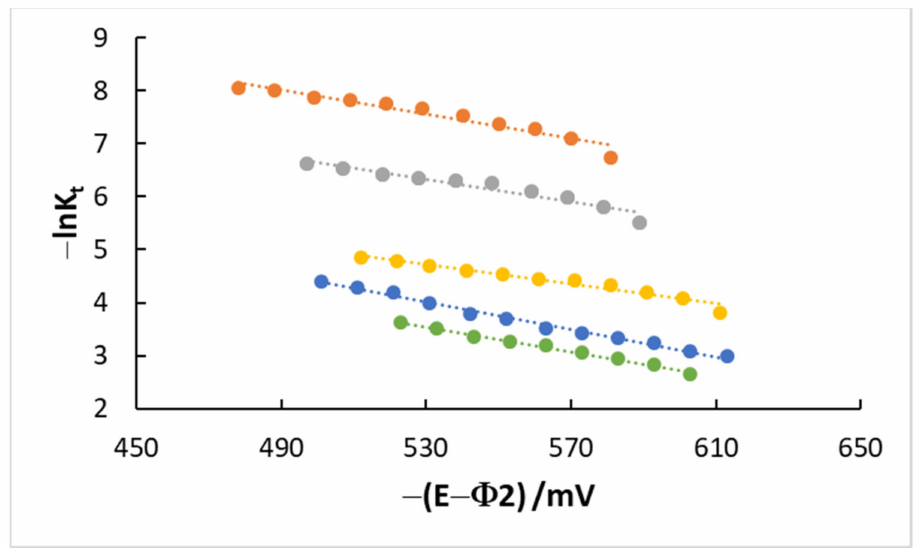
Figure 6. Plot of − lnK t vs. E − Φ 2 at different TEA concentrations (mM): 0 (green), 0.75 (blue), 2 (yellow), 5 (grey), 10